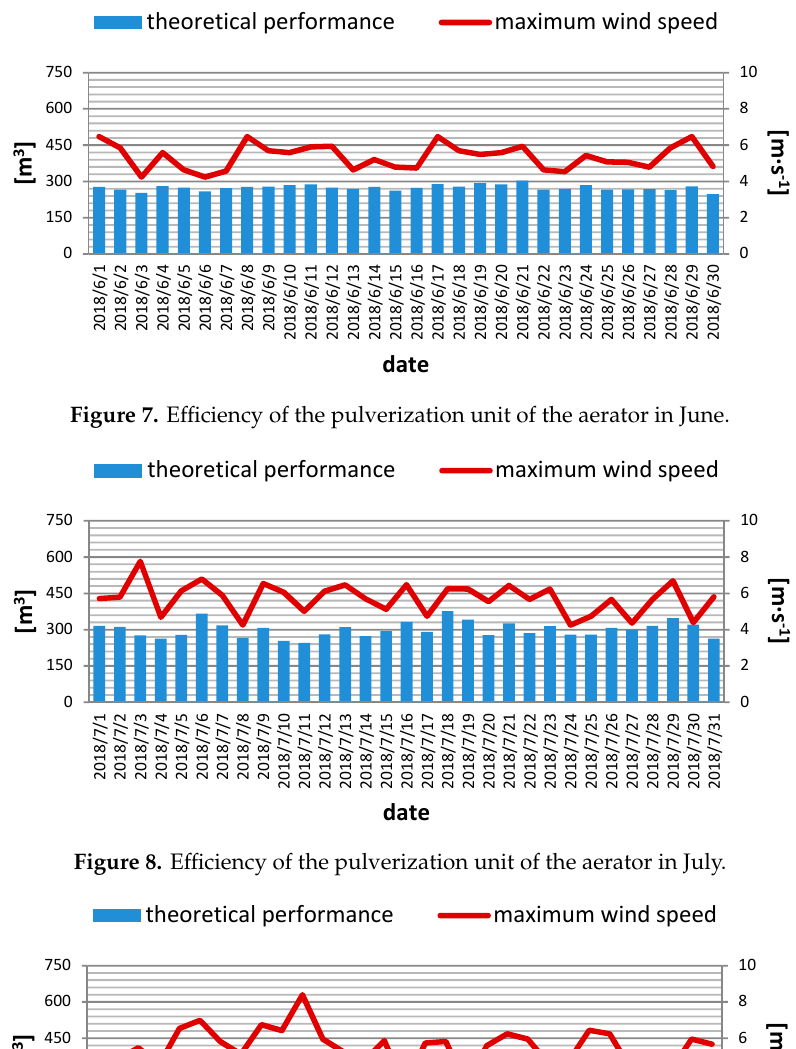
Figure 8. Efficiency of the pulverization unit of the aerator in July.